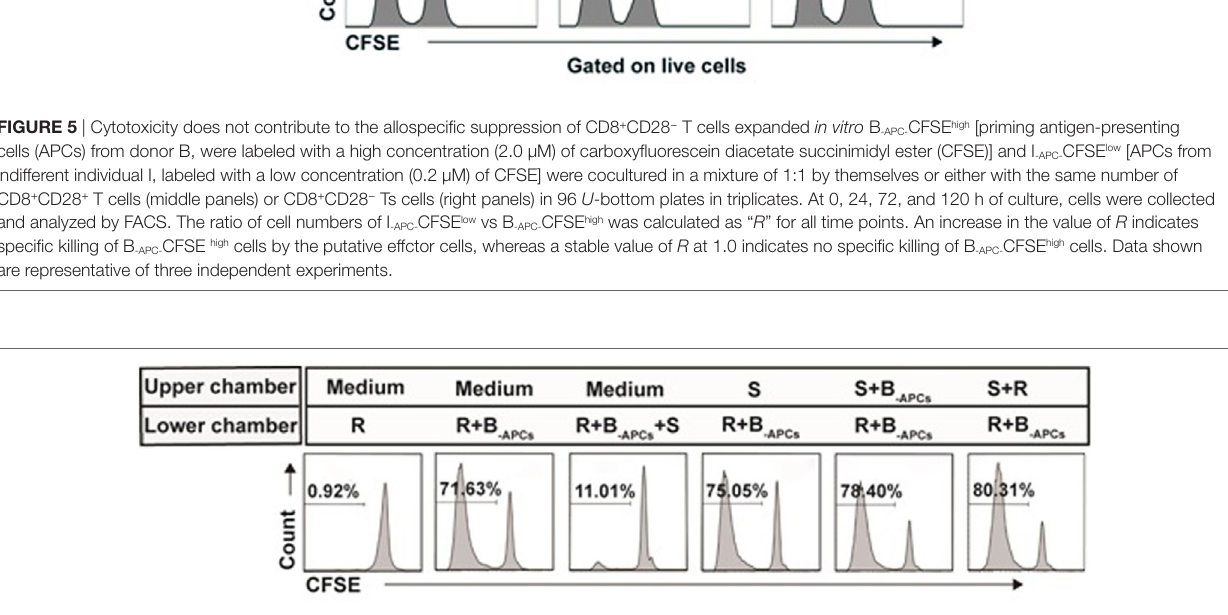
FigUre 6 | Suppression by the in vitro expanded CD8 + CD28 − T cells is contact dependent. Transwell assays: the lower chambers of 96-well transwell plates were plated with carboxyfluorescein diacetate succinimidyl ester (CFSE)-labeled responder cells (5 × 10 4 of CD4 + T cells, R) and stimulator cells (5 × 10 4 of B -APCs ), the in vitro expanded CD8 + CD28 − T cells (2.5 × 10 4 , S) were added either in the lower chamber to allow cell–cell contact or in the upper chamber to prevent cell–cell contact. The proliferation of the CD4 + T cells was measured by CFSE dilution assay. Data shown were representative of three independent experiments.